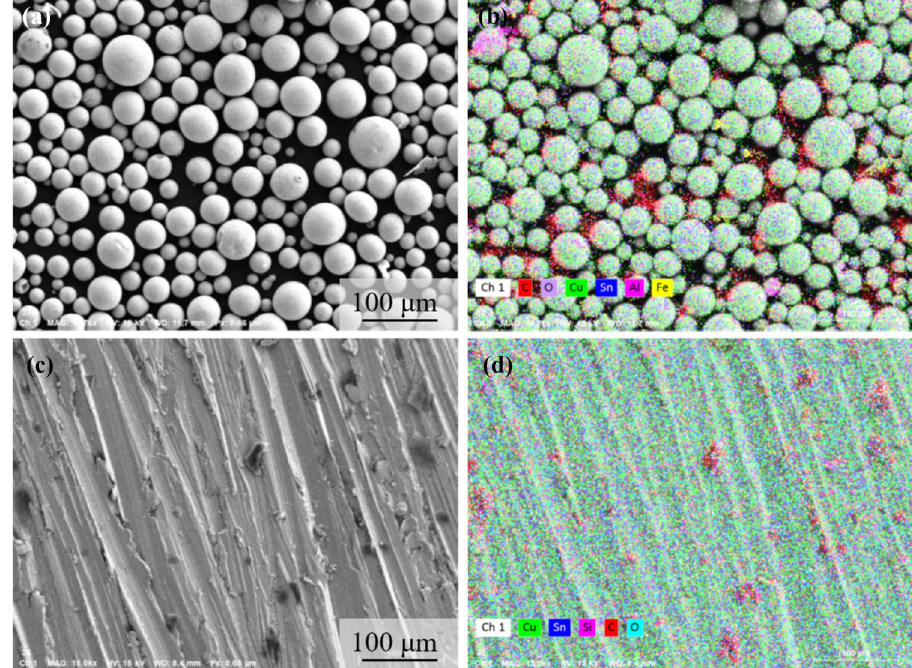
Fig. 7 SEM images of a powder particles and b machined workpiece surface as well as ( c ) and d their corresponding composition